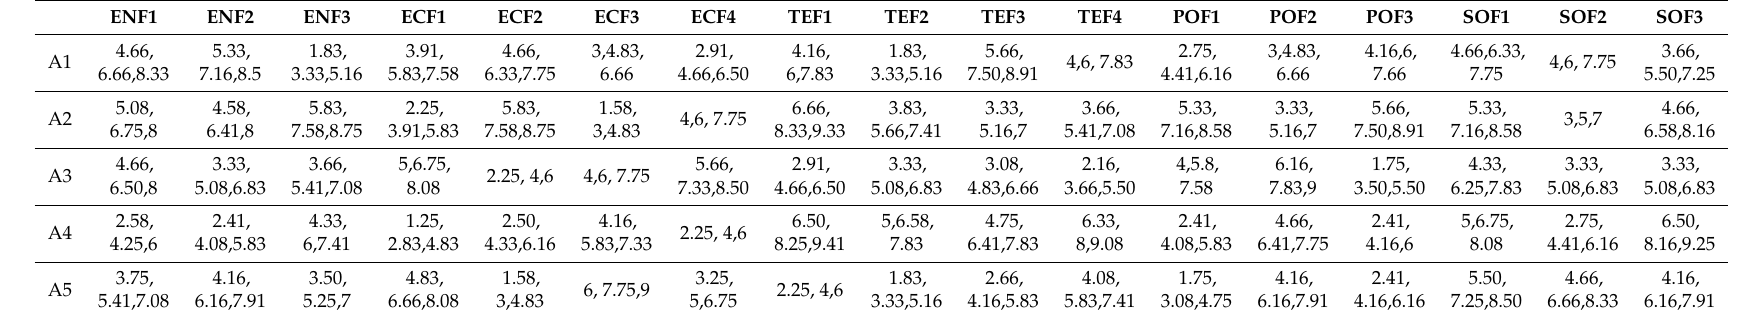
Table A9. Fuzzy integrated decision matrix.